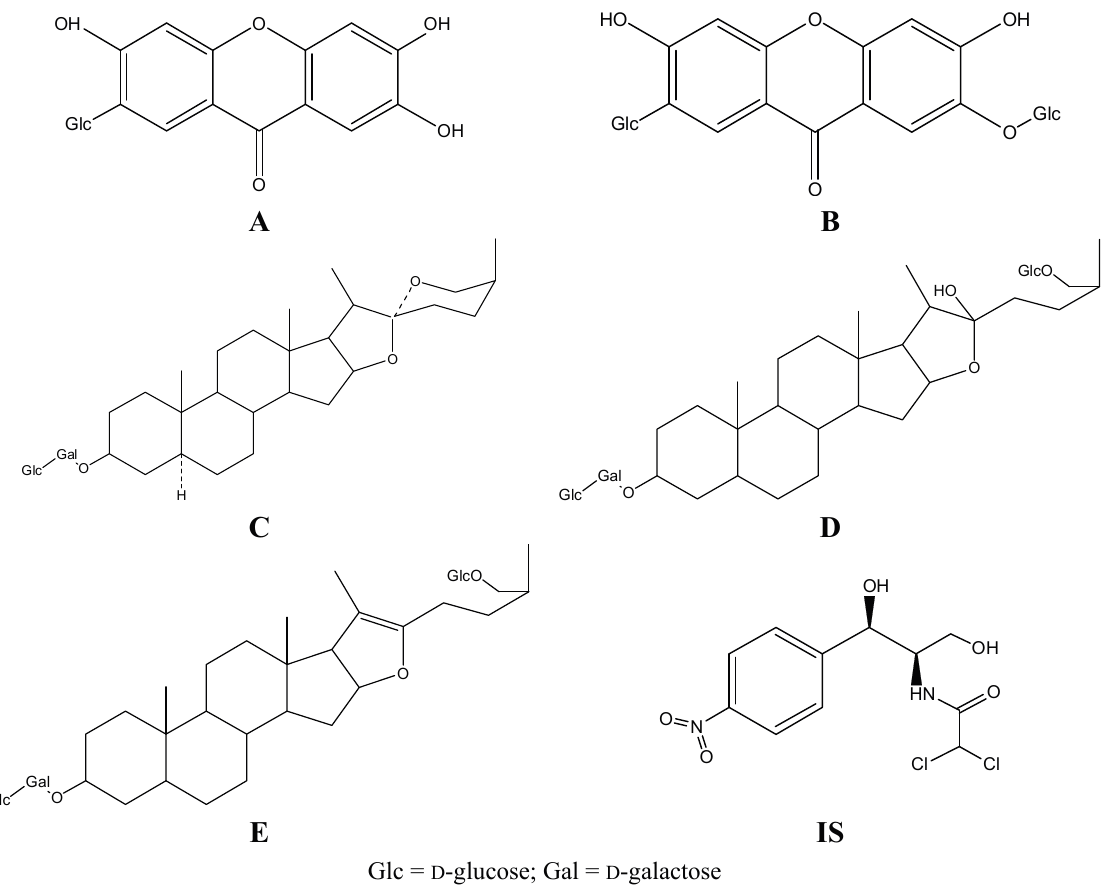
Figure 1. Chemical structures of mangiferin ( A ), neomangiferin ( B ), timosaponin BII ( C ) anemarsaponin BIII ( D ) and timosaponin AIII ( E ) and the internal standard chloramphenicol ( IS